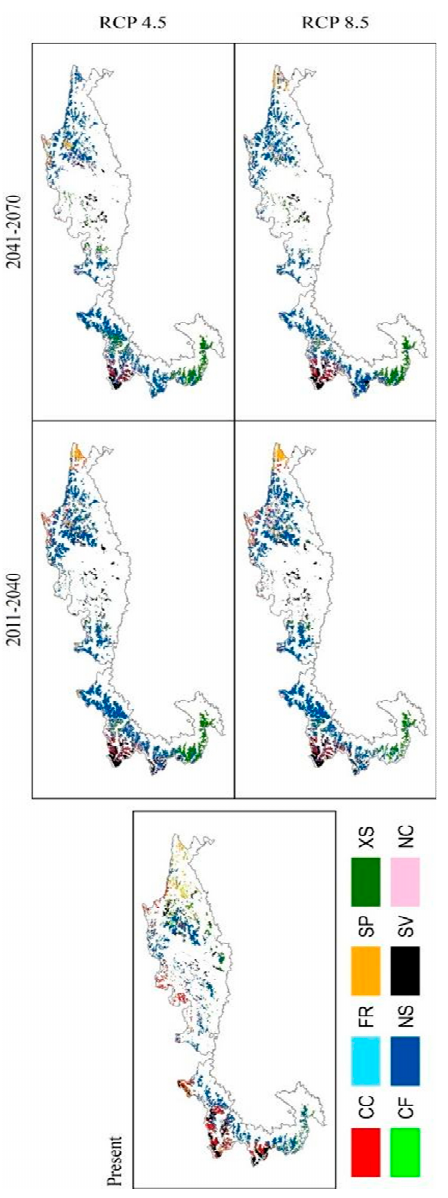
Figure 4. Grid cell map representing the distribution of the identified seven pasture macro-types across the Italian Alps in the present (left hand of the figure) and ensembled future time slices and RCP scenarios (right side of the figure). In red, pastures dominated by Carex curvula (CC); in light green, pastures dominated by Carex firma (CF); in light blue, pastures dominated by Festuca rubra (FR); in dark blue, pastures dominated by Nardus stricta (NS); in orange, pastures dominated by shrubs (SP); in black, pastures dominated by Sesleria varia (SV); in dark green, pastures dominated by xeric species (XS); in pink, unclassified (NC) pasturelands, located above 1000 m. For tabular data across the two main regions (Eastern and Western), see Tables S4 and S5.